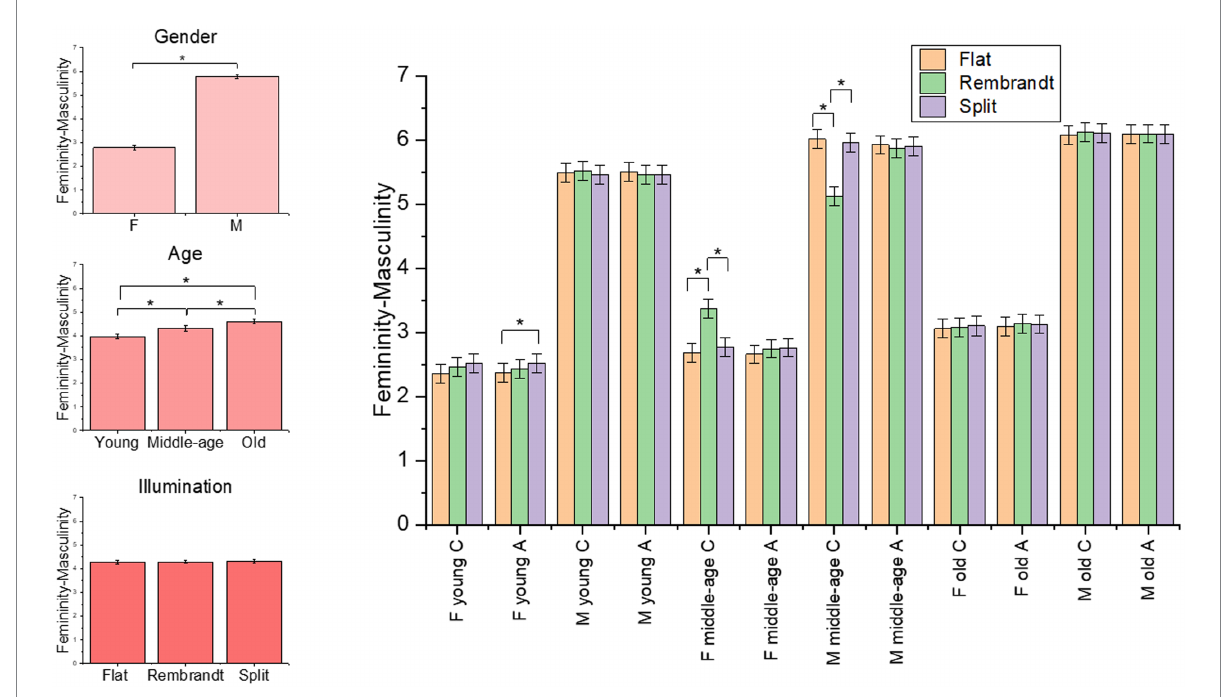
FIGURE 3 Plot of the estimated mean scores from the femininity-masculinity rating, depicting significant main effects and higher order interaction. The asterisks highlight the significant main effect and significant results form post hoc analyses. C = central gaze, A = averted gaze, F = female models, M = male models. Error bars represent mean standard